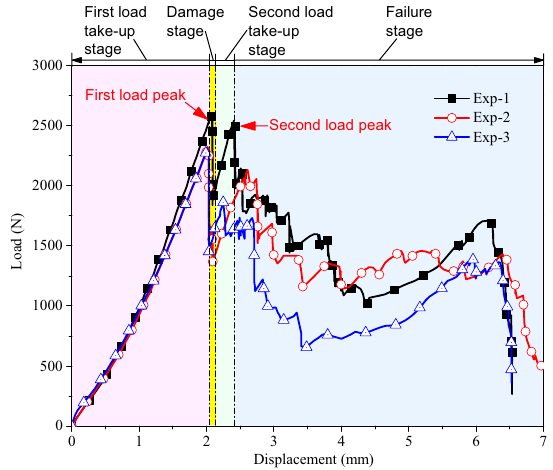
Figure 3 Load-displacement response of the pull-through test for composite/aluminum joints